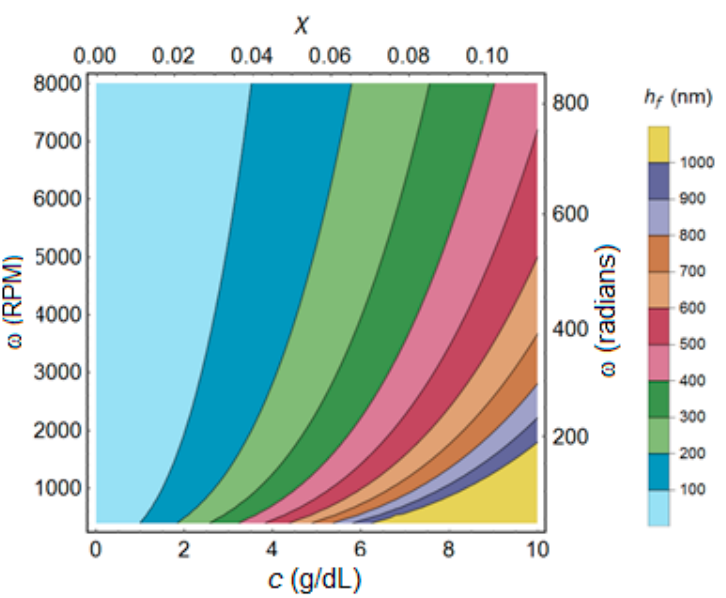
Figure 9. Contour plot of thickness as a function spin speed and solution concentration.